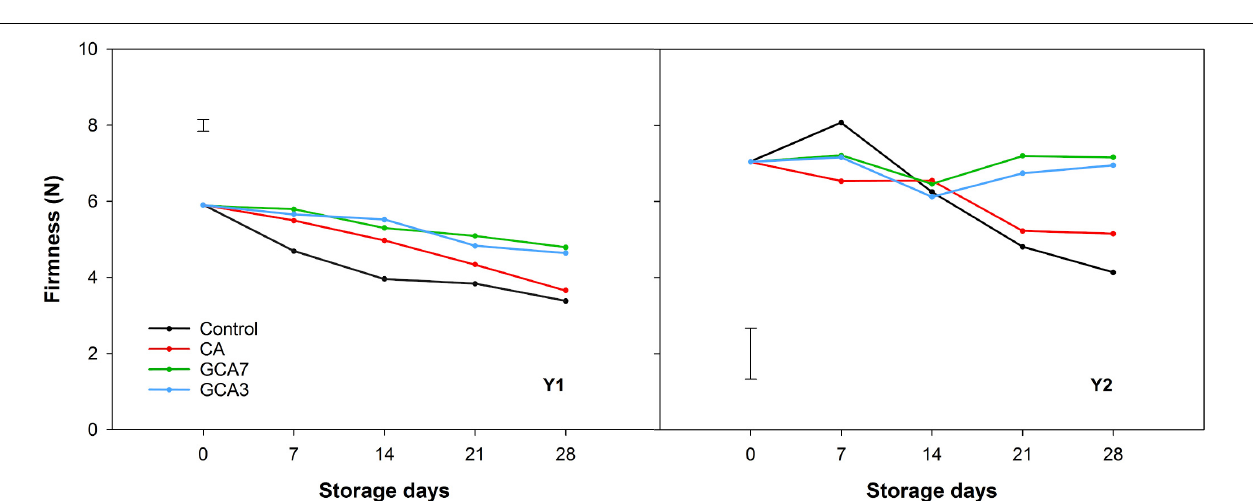
FIGURE 4 | Weight loss expressed as percentage (%) of “Duke” blueberry fruit subjected to controlled atmosphere (CA) applications throughout 28 days of storage at 0 ◦ C and 90–95 RH%; air [control]; standard CA (10 kPa CO 2 + 5 kPa O 2 ); graduated CA 7 (GCA7; 7 days to achieve standard CA values); and GCA3 (3 days to achieve standard CA values). Two consecutive seasons are considered 2017 (year 1; Y1) and 2018 (Y2). Data represents means ( n = 3). Least Significant Differences (LSD) are included as: LSD treatment ∗ time = 1.0145 for Y1 and LSD treatment = LSD time = 0.2338 for Y2.